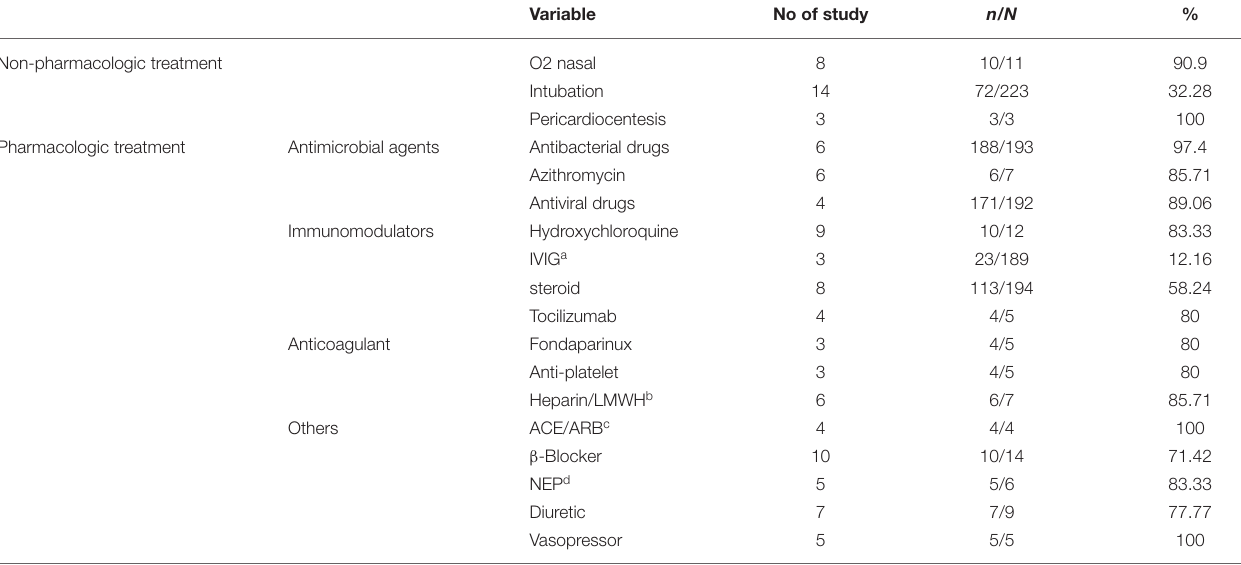
TABLE 5 | Treatment agents used in the included